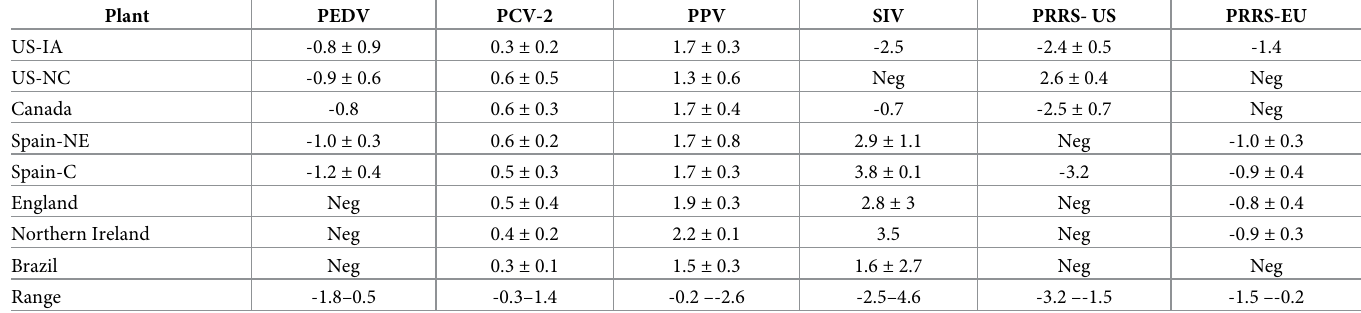
The S2 Table (Raw Plasma) includes estimated viral levels in unprocessed plasma reported as log TCID /g. It is important to recognize that a positive PCR/RT-PCR does not imply infec- 10 50 tivity [16], a fact that was observed for all the viruses studied in the present work. In this survey neither SVA, TGEV nor SDCoV were detected in any of the SDPP samples. SVA infection has been detected in the Americas and Asia, but not in Europe [30]. Viremia and clinical signs in SVA infected pigs appear within 2 to 3 days post-inoculation and last for few days [31, 32]; therefore, there was minimal chance of an infected pig being undetected at the farm or during antemortem inspection. Despite SVA infected animals have been sporadi-